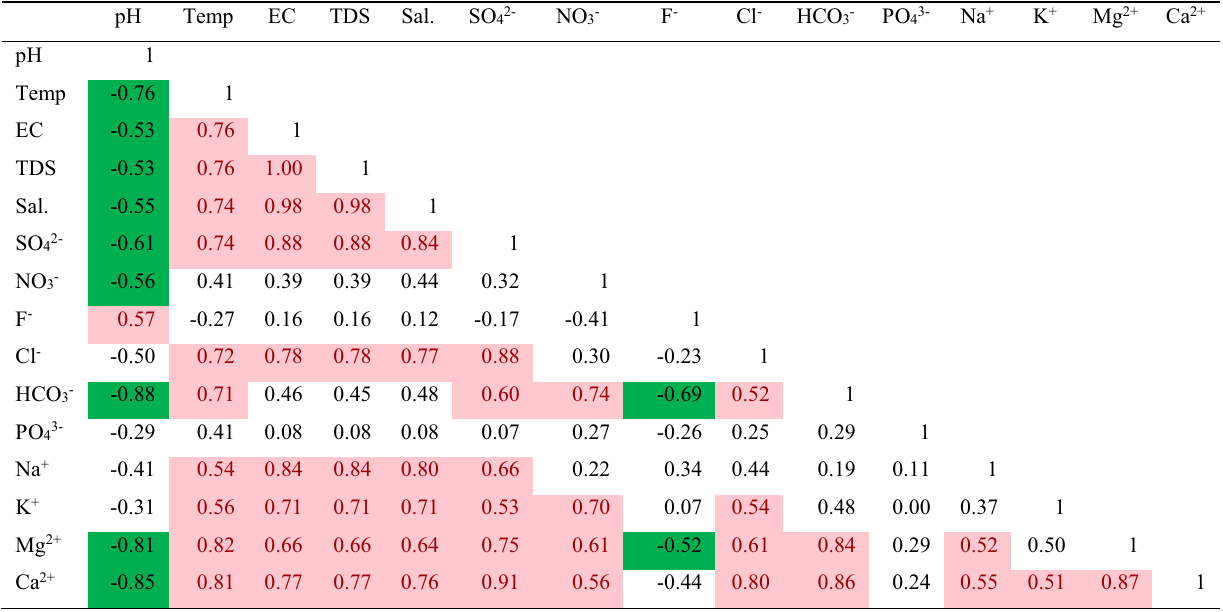
Table 3 Pearson correlation matrix for samples from spring water pH Temp EC TDS